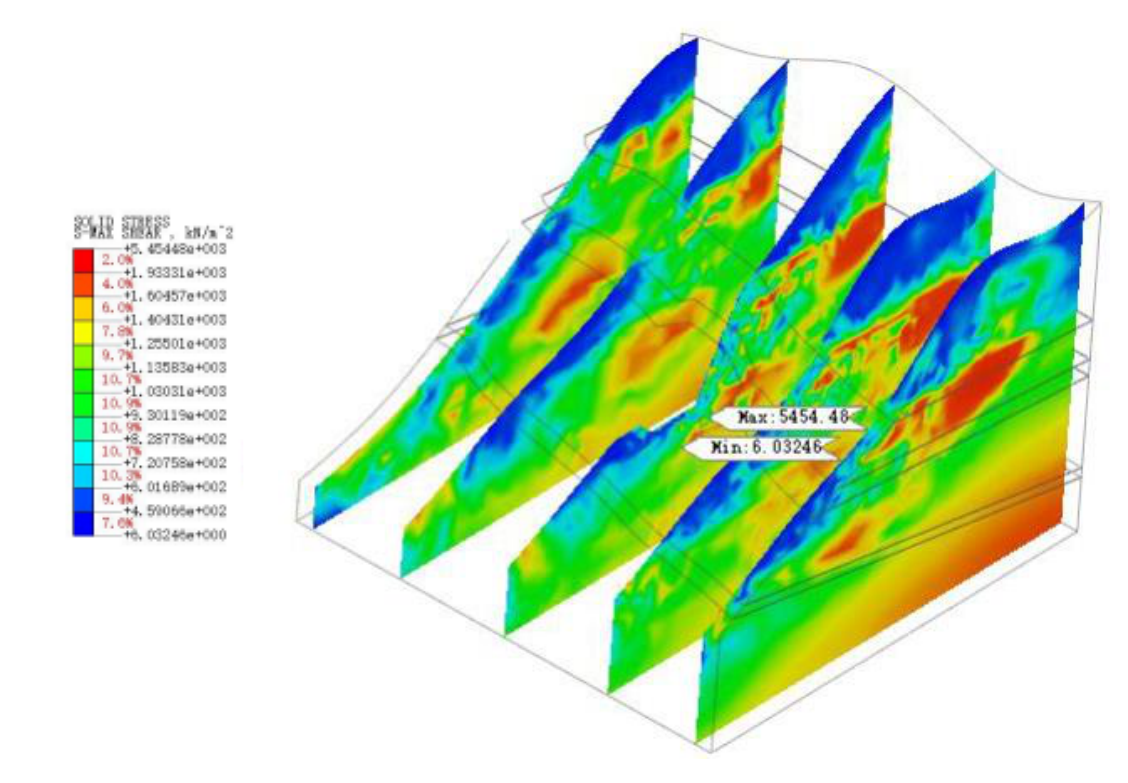
Figure 24. The maximum shear stress of slope.